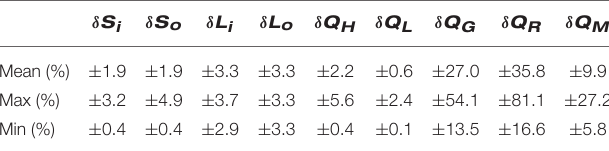
TABLE 2 | Range of the daily average error values (% of mean fluxes) calculated for the eight observed fluxes and Q M